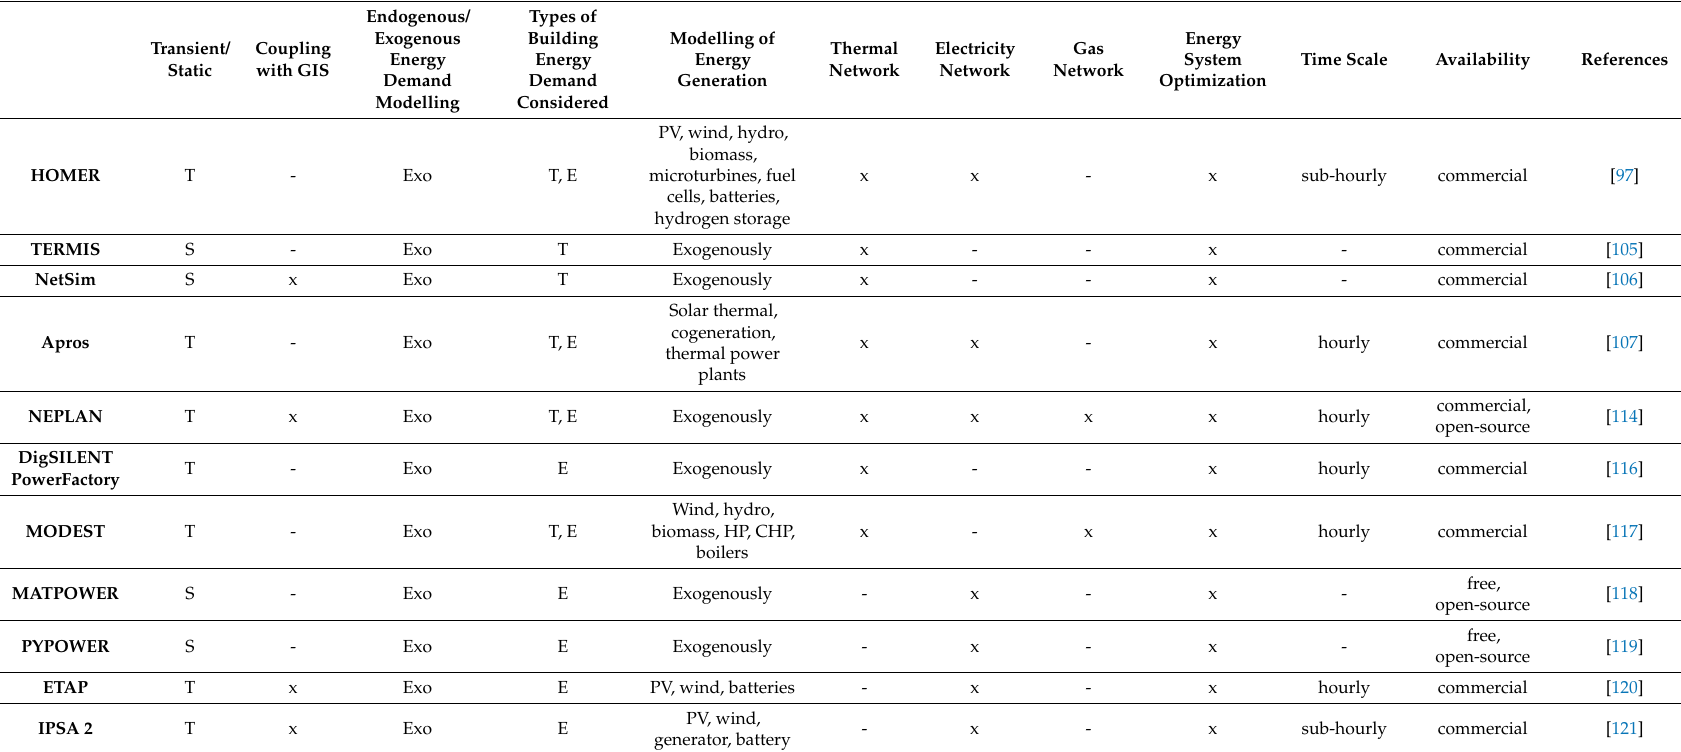
Table 2. Characteristics of reviewed simulation tools for building energy supply in